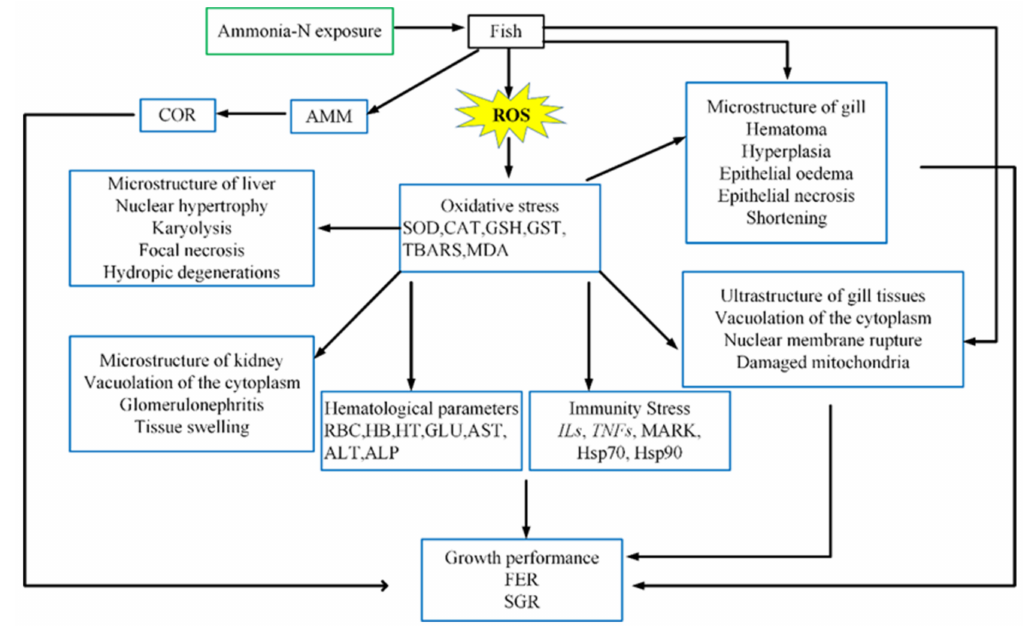
Figure 1. Toxicological characteristics and physiological response process for fish exposed to ammonia [11]. AMM: ammonia; COR: cortisol; SOD: superoxide dismutase; CAT: catalase; GSH: glutathione; GST: Glutathione S-transferase; TBARS: Thiobarbituric reactive substances; MDA: malon dialdehyde; RBC: red blood cell count; Hb: hemoglobin; Ht: hematocrit; GLU: glucose; AST: aspartate transaminase; ALT: alanine transaminase; ALP: alkaline phosphatase; Ils : interleukins; TNFs : tumor necrosis factors; FER: feed efficiency ratio; SGR: specific growth—Reprinted with permission from ref. [11]. Copyright 2019